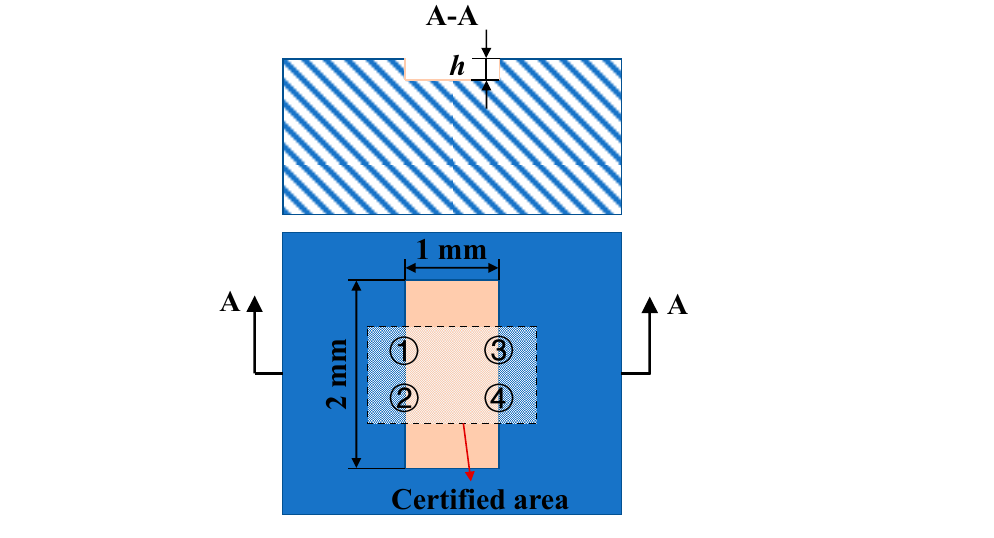
Figure 6. Cross section of step height standard.